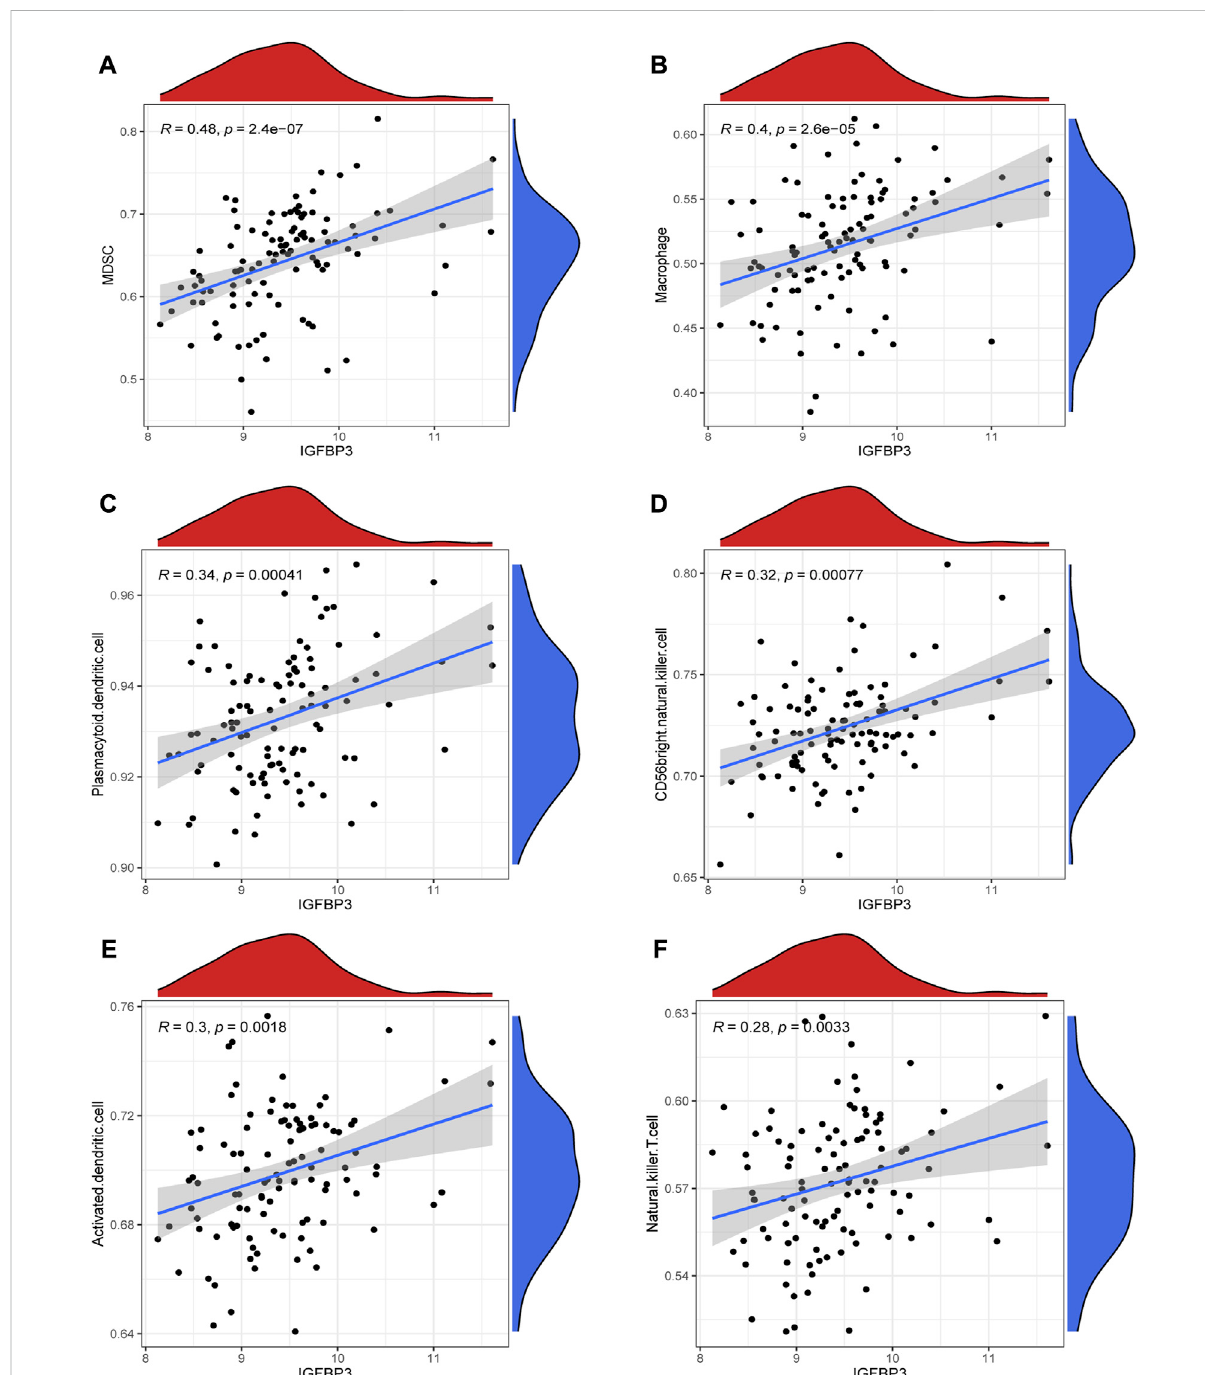
FIGURE 6 Correlation between IGFBP3 and immune cells in hypertrophic myocardiopathy (HCM) using spearman correlation analysis. (A) Correlation betweenIGFBP3andMDSC. (B) CorrelationbetweenIGFBP3andmacrophage. (C) CorrelationbetweenIGFBP3withplasmacytoiddendriticcell. (D) Correlation between IGFBP3 with CD56 bright natural killer cell. (E) Correlation between IGFBP3 with activated dendritic cell. (F) Correlation between IGFBP3 with natural killer T